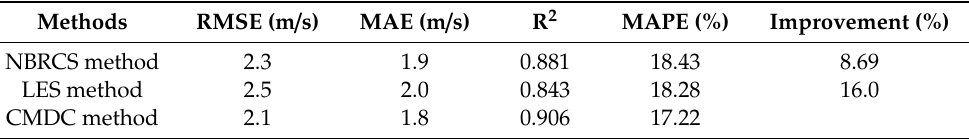
Figure 17. Scatter plot of CMDC estimation of wind speed and ECMWF wind speed. Colors (from cold to warm) represent data density. Table 2. The RMSE, MAE, R 2 , and MAPE of wind speed estimated by NBRCS, LES, and CMDC methods (the sixth column is the accuracy improvement of the CMDC method compared with the other two methods).